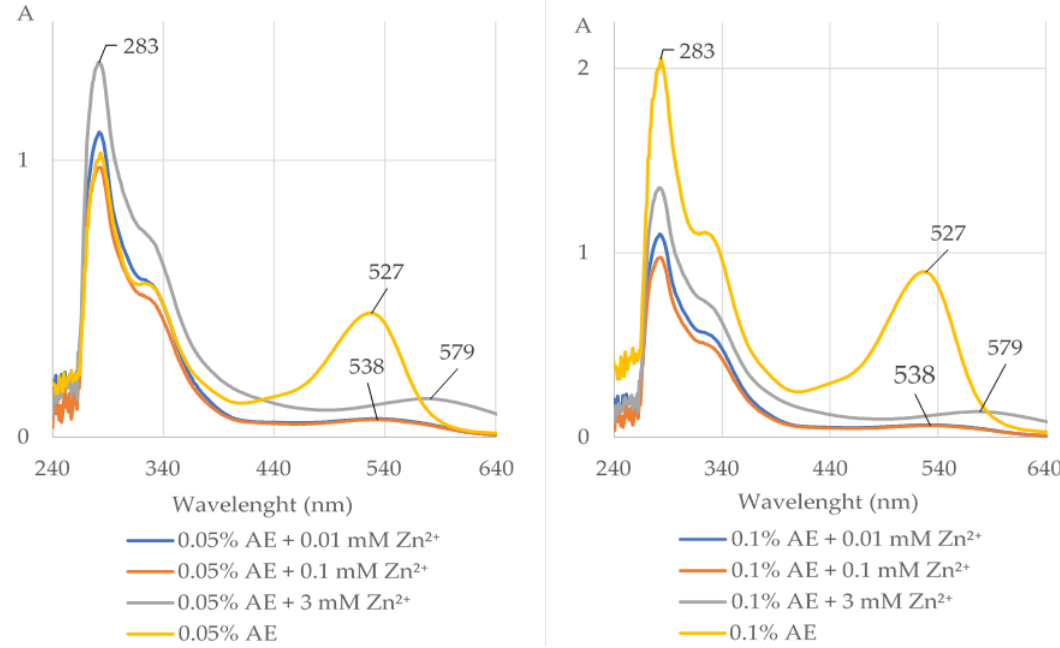
Figure 1. The UV–Vis absorption spectra (with indicated maximum absorption) of the extract from Aronia melanocarpa L. berries (0.05% and 0.1% AE) alone and after addition of divalent ions of zinc (Zn 2 + ) at the concentrations of 0.01, 0.1, and 3 mM at pH 5.5. The shift of the maximum absorption after addition of Zn 2 + to the AE indicates that the extract chelated these ions. A, absorbance.